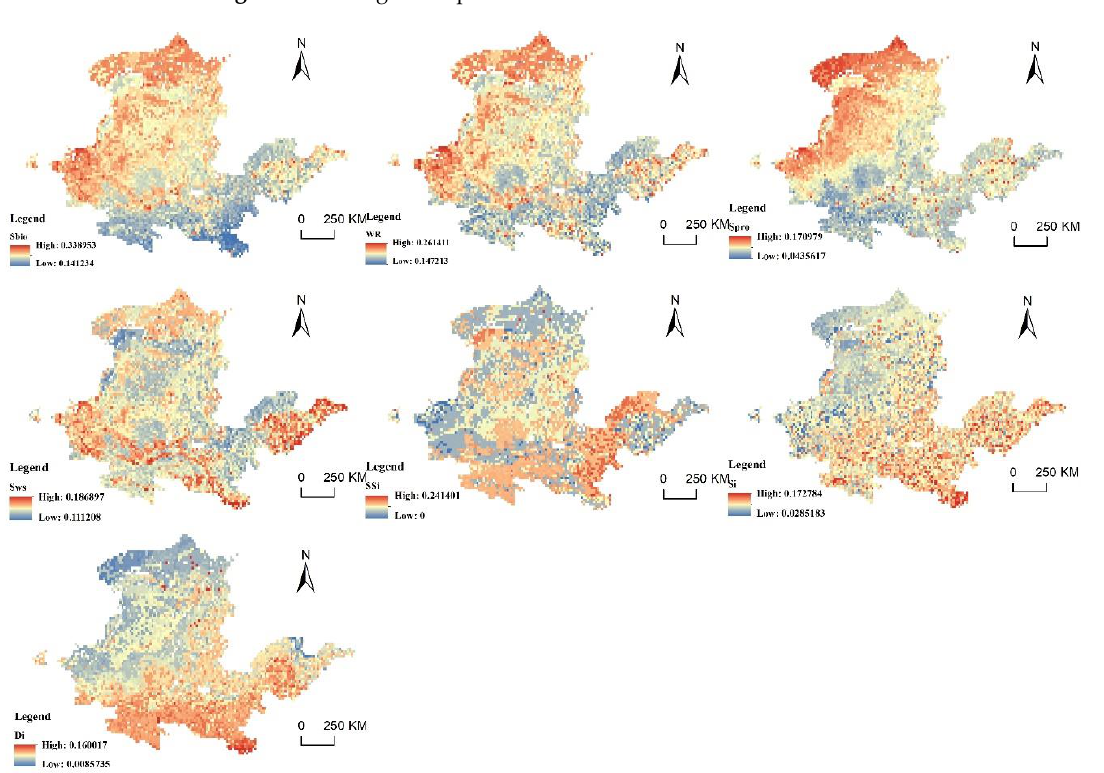
Figure 11. Ecological-importance barriers in 2015.